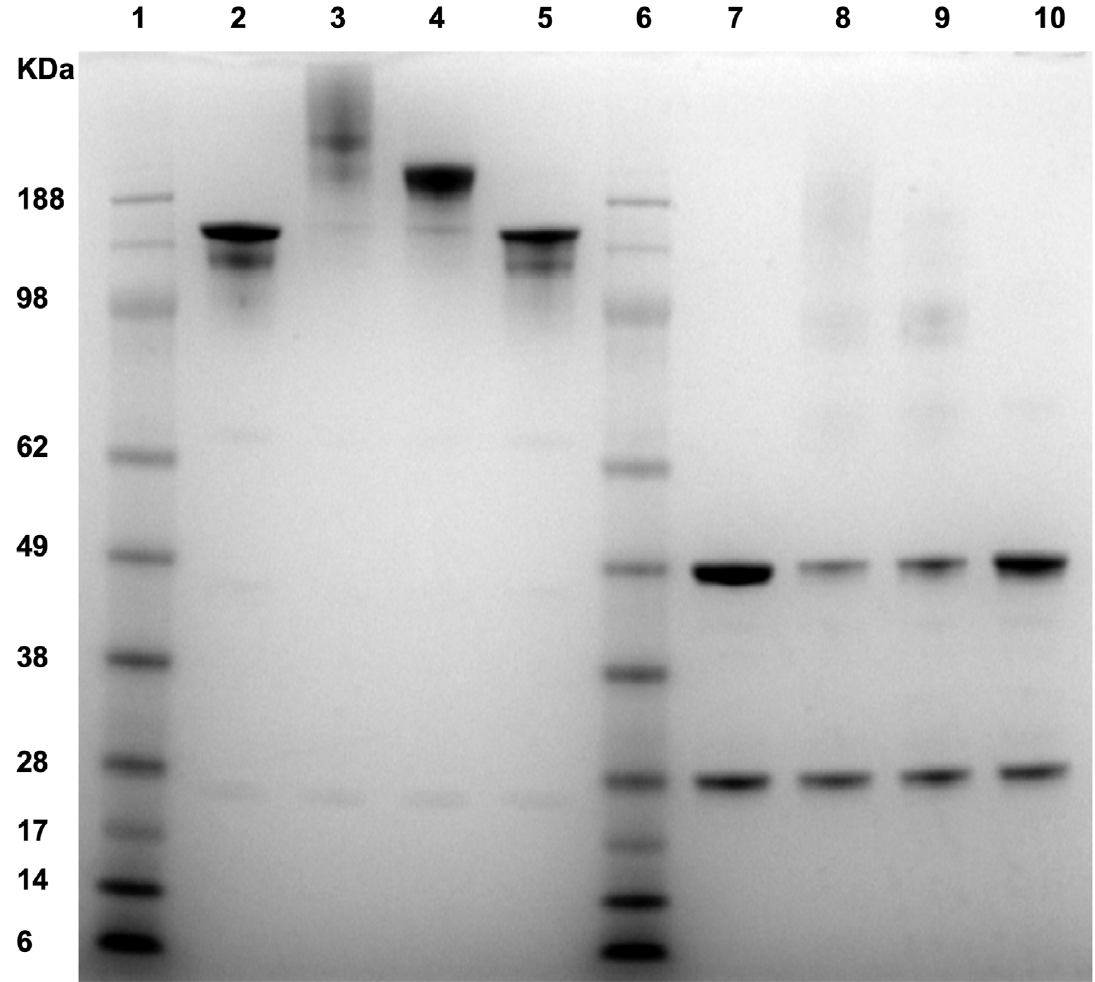
Figure 3. Sodium dodecyl sulfate polyacrylamide gel electrophoresis (SDS-PAGE) of the collected fractions from SEC. Lane 1: protein standards; lane 2: non-reduced control sample (no AAPH stressed mAb1); lane 3: non-reduced higher- order aggregates; lane 4: non-reduced dimer; lane 5: non-reduced monomer; lane 6: protein standards; lane 7: reduced control sample (no AAPH stressed mAb1); lane 8: reduced higher-order aggregates; lane 9: reduced dimer; lane 10: reduced